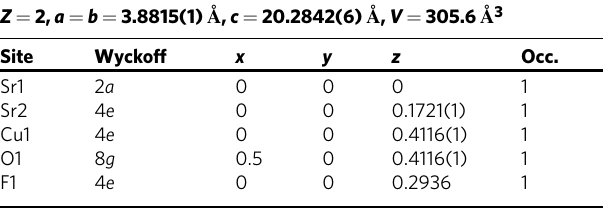
The atomic displacement parameter, U iso , was commonly set for all atoms and converged to 0.029(1) Å 2 . The site occupancies, Occ., were fi xed for all crystallographic sites.